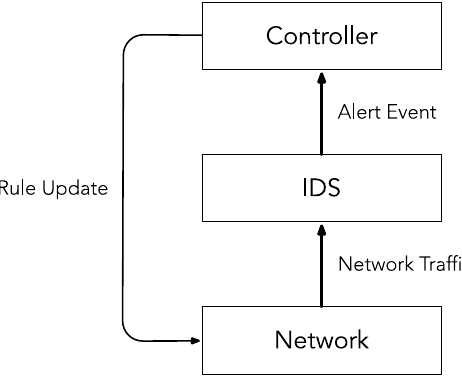
Figure 1. The System’s Basic Architecture.